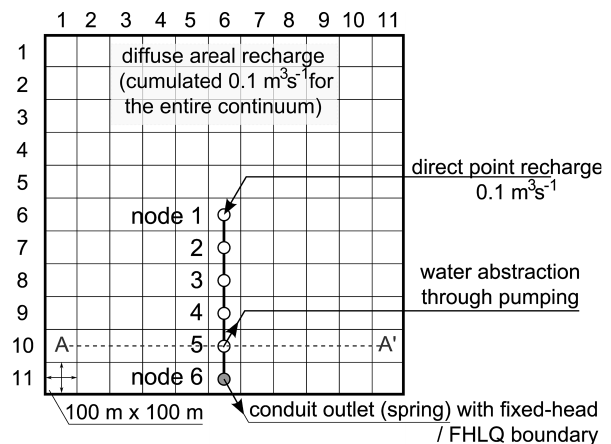
Fig. 5. Sketch of the model setup used for testing the CADS and FHLQ